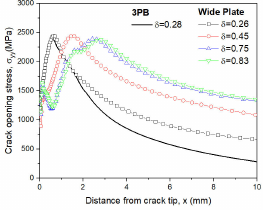
Figure 7. Opening stress distributions of WP and 3PB specimens under di ff erent